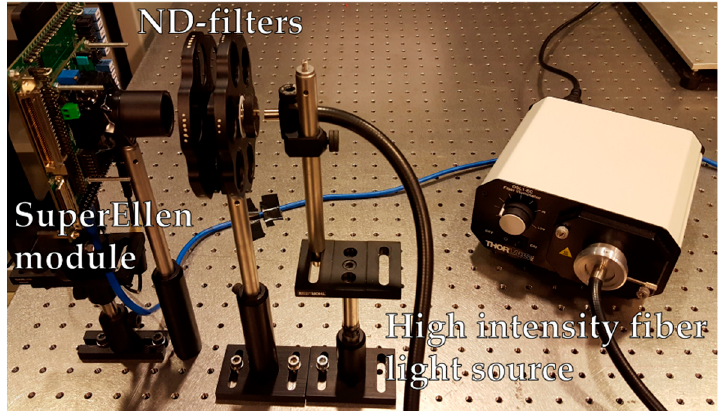
Figure 4. Experimental set-up to characterize the sensor dynamic range (DR).